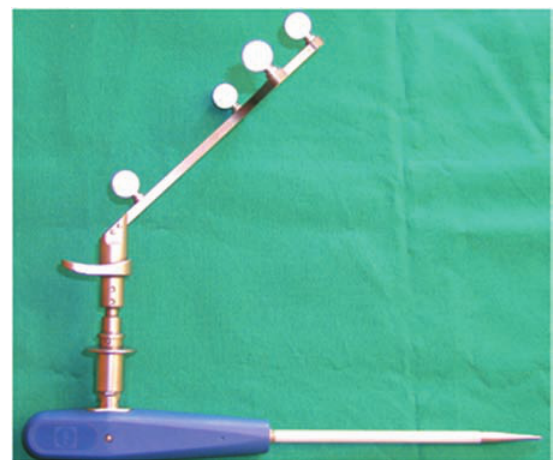
Figure 2 - The suture wire was pulled through the femur by the guide wire out to the anteromedial femoral metaphyseal surface.